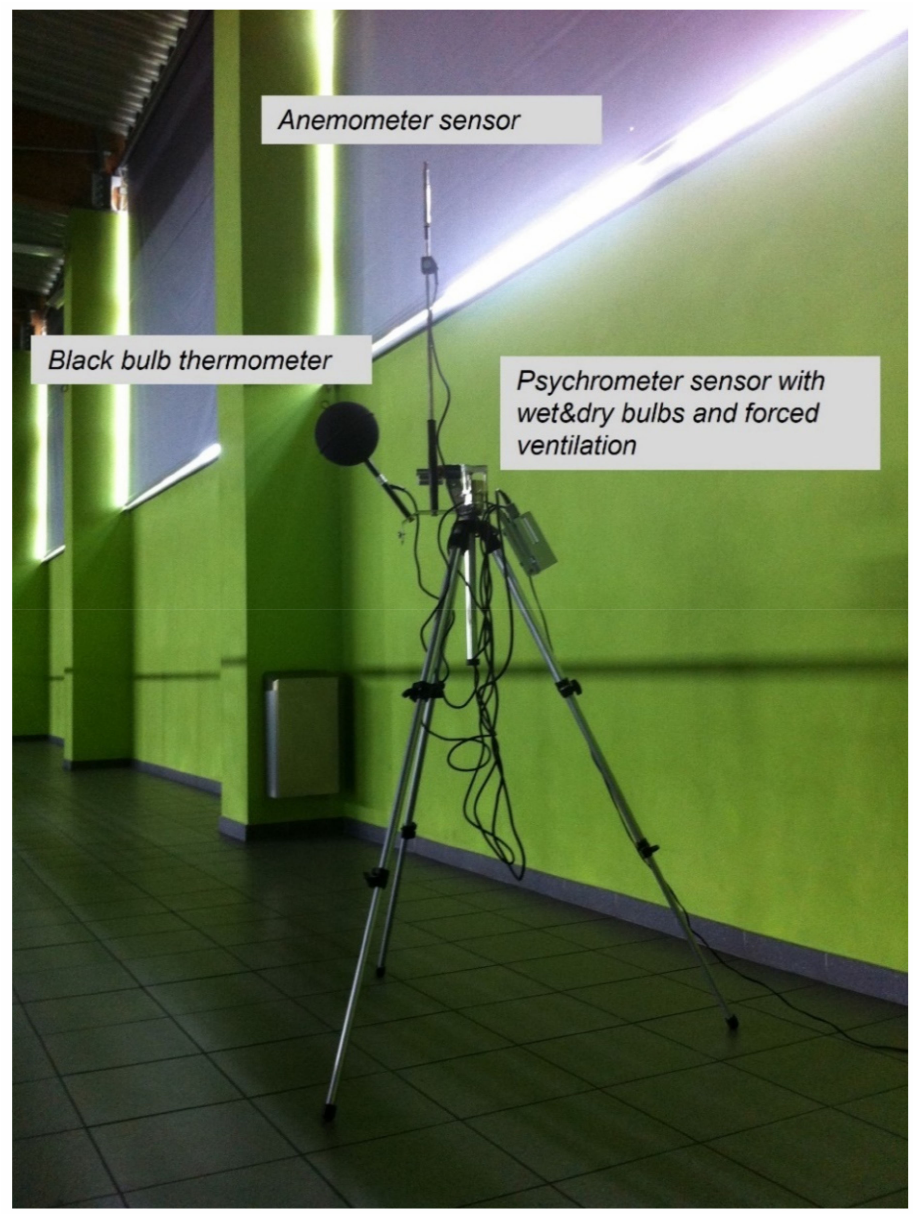
Figure 3. Digital microclimate meter Babuc A (author’s